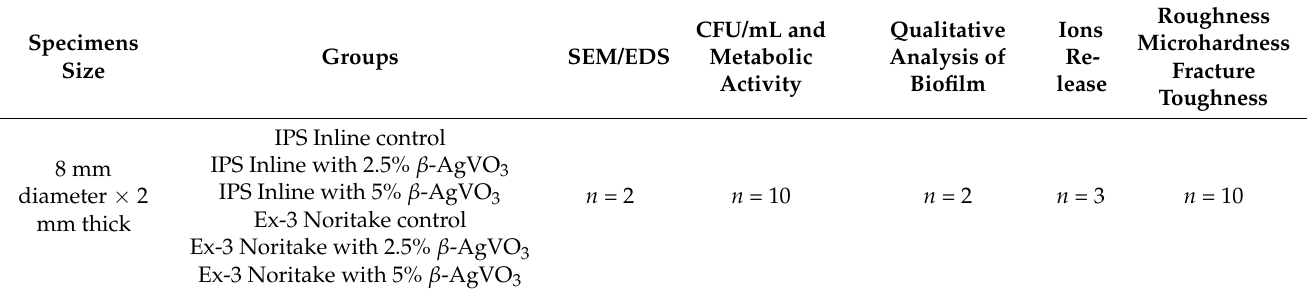
Table 4. Specimen specifications and number of samples ( n ) by